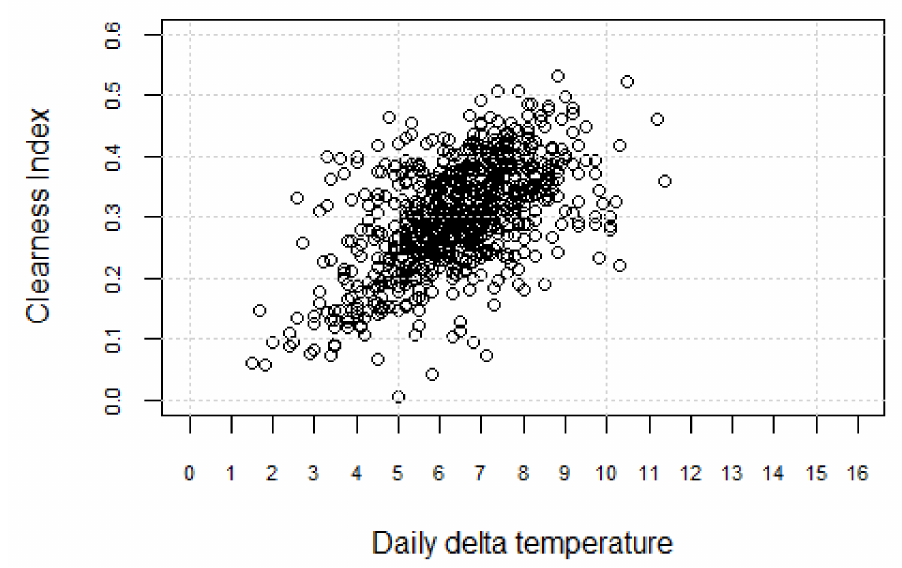
Figure 10. Daily delta of temperature–clearness index for Guapi .